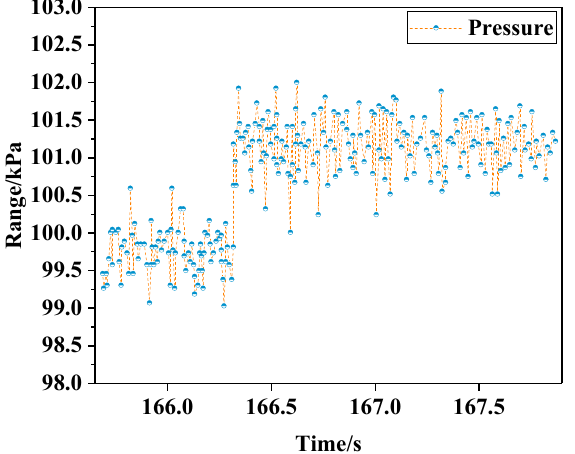
Figure 6. Measured flashover air pressure.